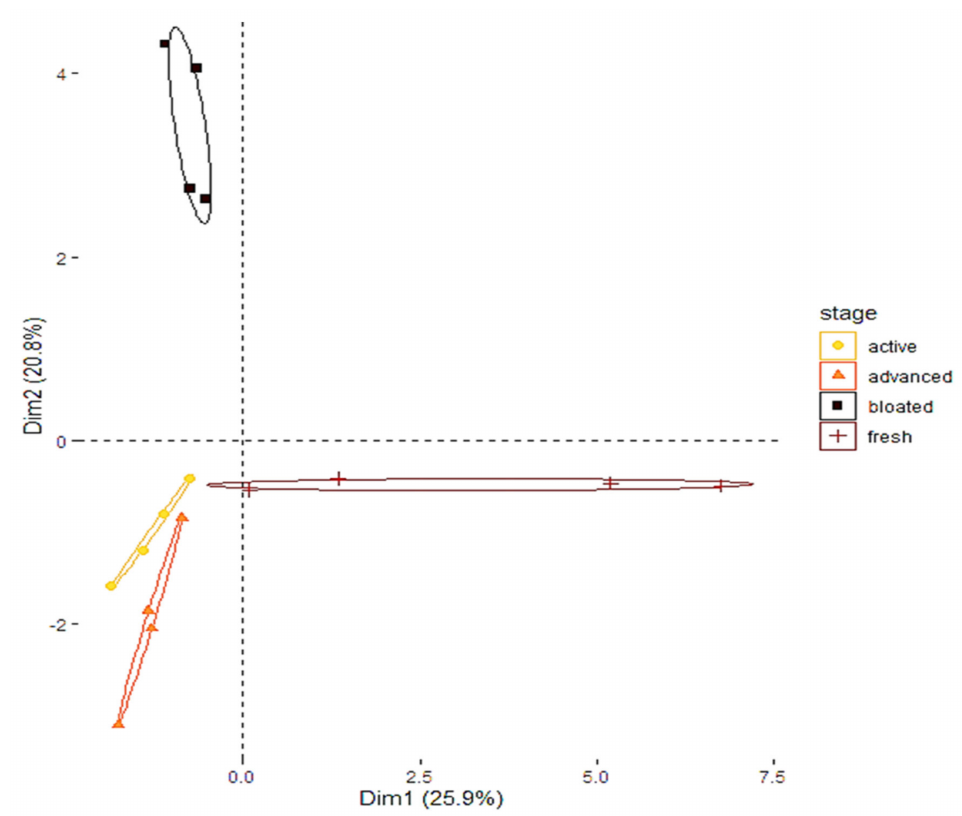
Figure 2. Principal component analysis displaying the contrasted composition of the cadaveric COVs collected from each stage of decomposition.